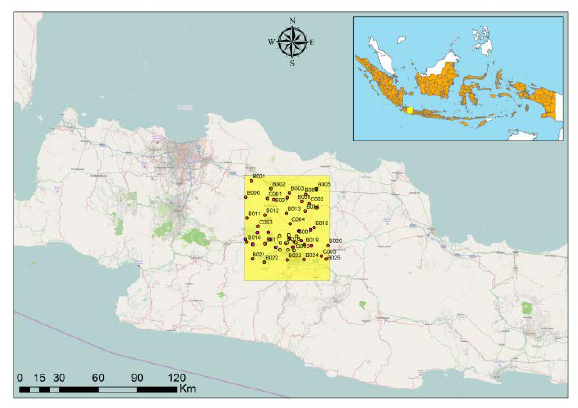
Figure 2. Test area (Bandung, Indonesia)